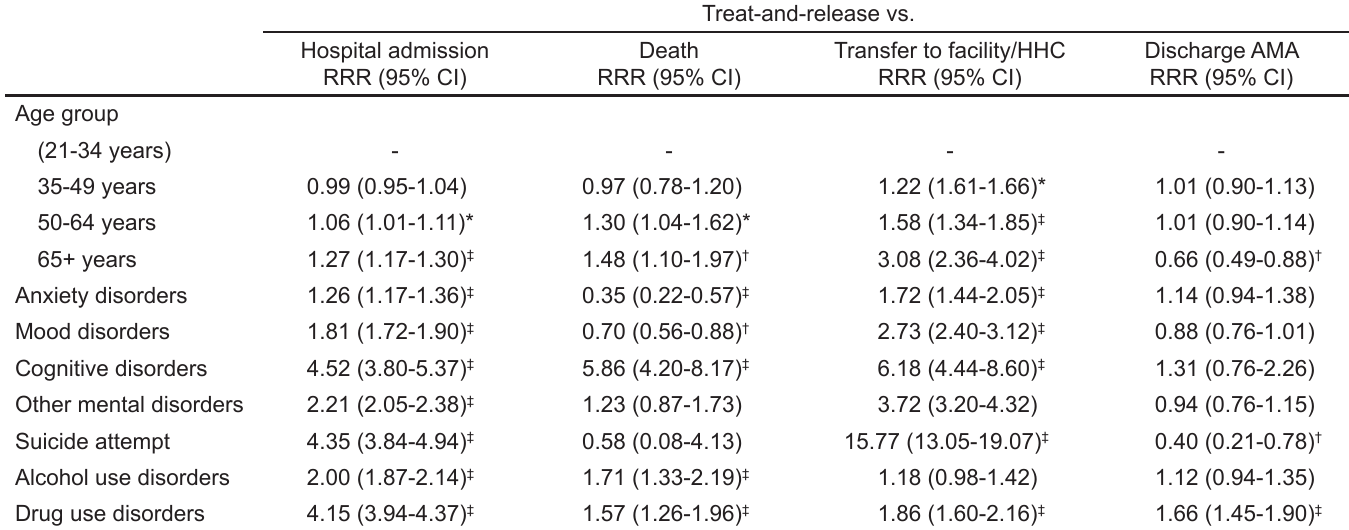
Table 4. Associations of age group and mental health and substance use disorders with emergency department (ED) outcomes among ED visits by persons with HIV diagnosis: Relative risk ratios (RRR) and 95% confidence intervals (CI) from multinomial logistic regression